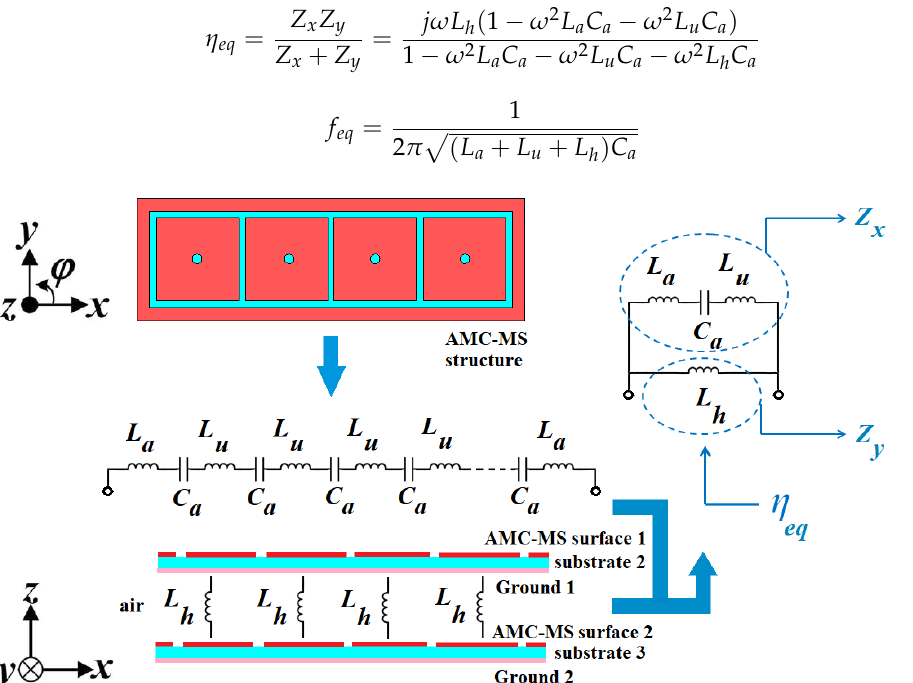
Figure 7. Equivalent circuit model of the proposed AMC-MS unit